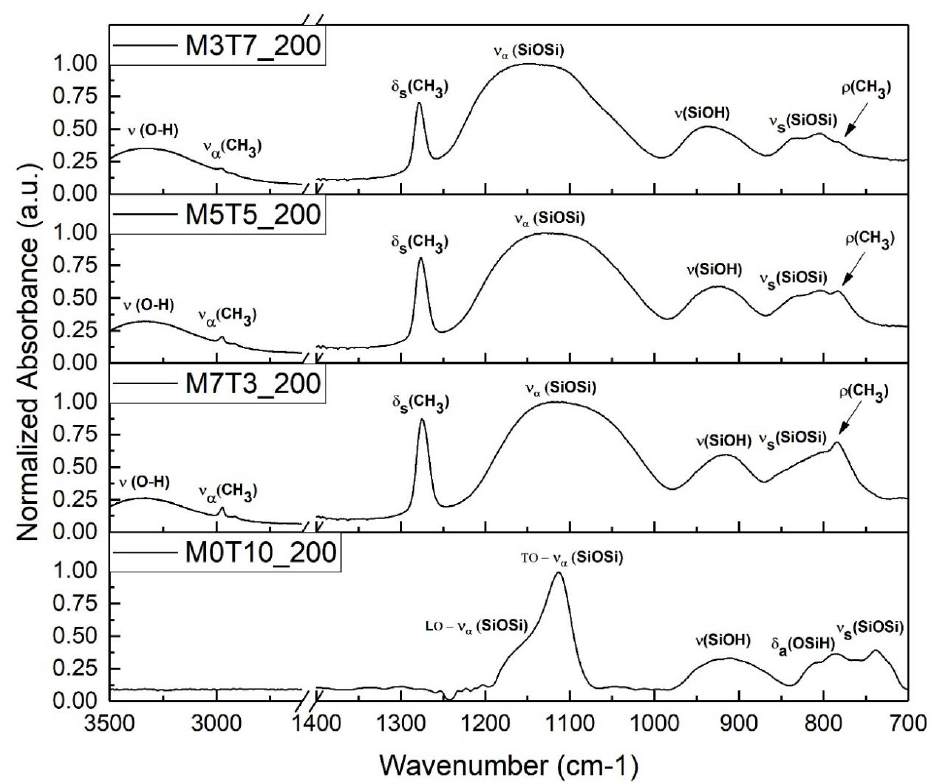
Figure 3. Fourier-Transform Infrared (FTIR) spectra of M7T3 coatings changing the precursors’ concentration, compared with a silica coating.